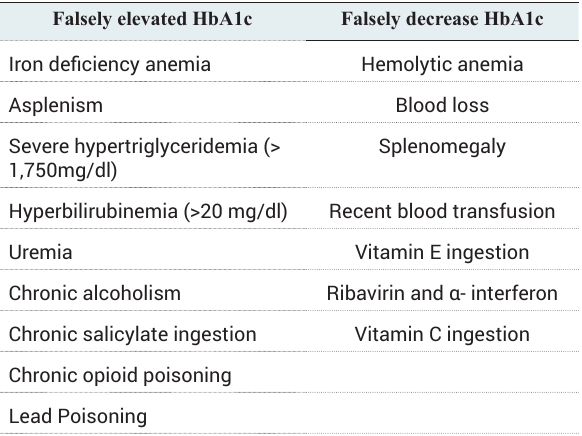
Table 1: Common causes which interferes with the HbA1c value